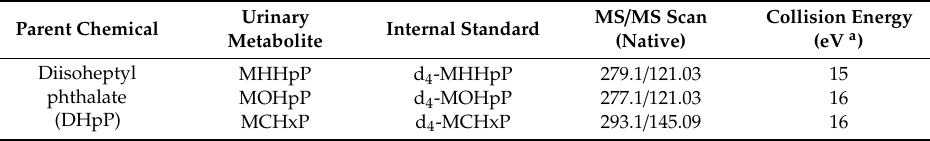
Table 1. Analytical parameters for the quantification of diisoheptyl phthalate metabolites.